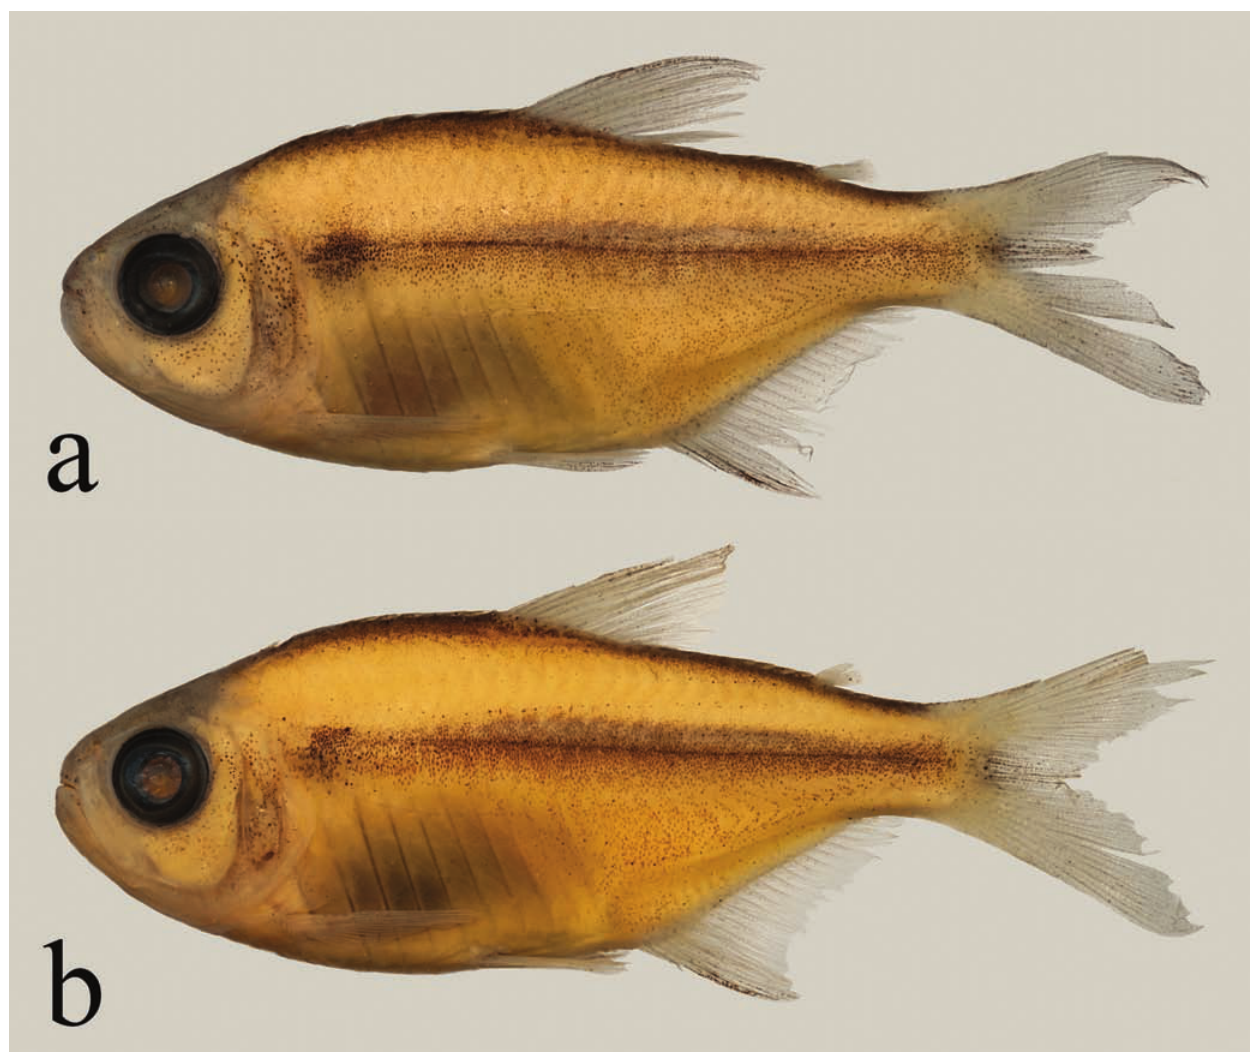
Fig. 1. Moenkhausia rubra , Brazil, Mato Grosso, Sapezal, Pequena Central Hidrelétrica (PCH) Sapezal, rio Juruena, rio Tapajós basin: (a) LIRP 8183, holotype, female, 41.3 mm SL, (b) LIRP 8164, paratype, male, 47.4 mm